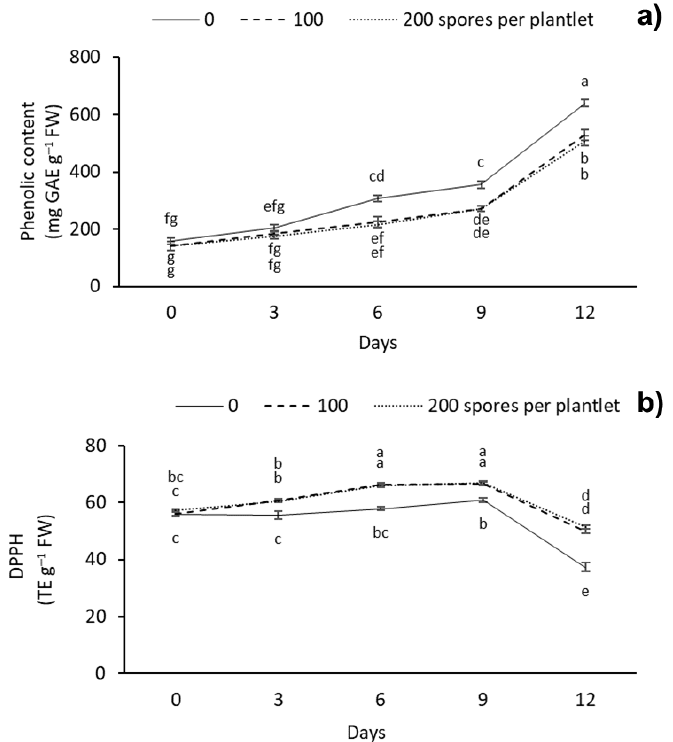
Figure 6. Effect of different doses (0, 100, and 200 spores per plantlet) of arbuscular mycorrhizal fungi ( Glomus intraradices ) on sugarcane plantlets ( Saccharum spp. cv Mex 69-290) evaluated under drought stress during acclimatization stage. ( a ) Phenolic content expressed in GAE (milligrams of gallic acid equivalents per g of fresh weight) and ( b ) antioxidant capacity expressed in DPPH (2,2-Diphenyl–1-picrylhydrazyl), trolox equivalents (TE) per g of fresh weight. Results are shown as mean ± standard error. Means with different letters (a–g) are significantly different (Tukey, p < 0.05).